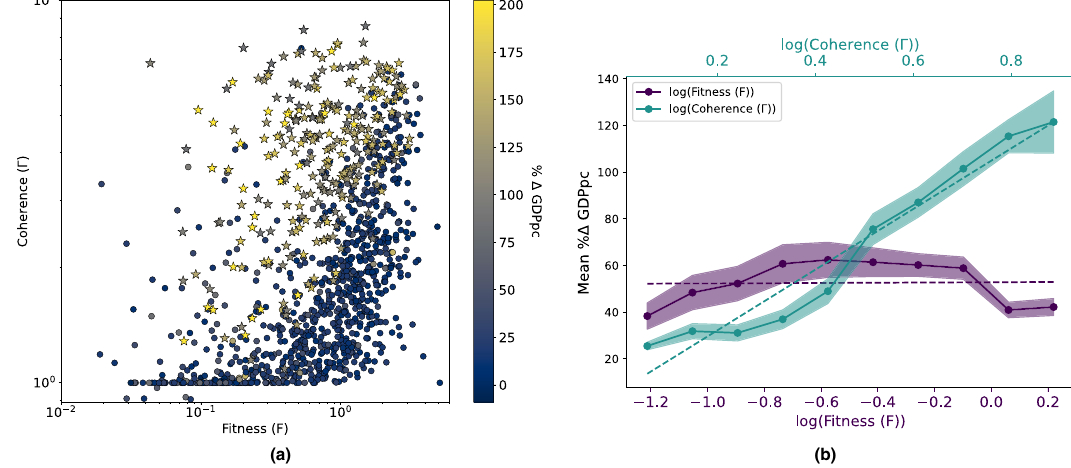
Figure 5. Fitness VS coherence to evaluate GDPpc growth. (a) Fitness–coherence plane. We represent the averages of the measures over the decade 1995–2005, and the colour scale is the fractional change of GDPpc over the years. We observe how the Coherence allows discriminating MAs with a more significant positive change in GDPpc. Stars indicate the Chinese MAs. (b) Average fractional change of the GDPpc versus Fitness and Coherence. To highlight that Coherence correlates better with changes in GDPpc, we divide Fitness and Coherence into ten bins and calculate the mean fractional GDPpc variation of all the points in each of the ten bins. The Fitness curve is roughly constant, highlighting that Fitness cannot discriminate different fractional changes of the GDPpc; this is in part due to rich metropolitan areas with high Fitness and with a rather stable GDPpc. Coherence, instead, displays a growing trend with the fractional change of GDPpc, i.e. the higher the Coherence, the higher % (cid:31)